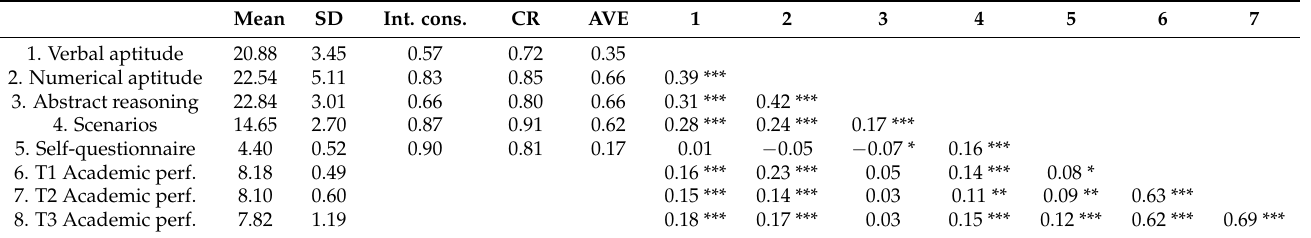
Table 1. Descriptive statistics and correlations of variables in the